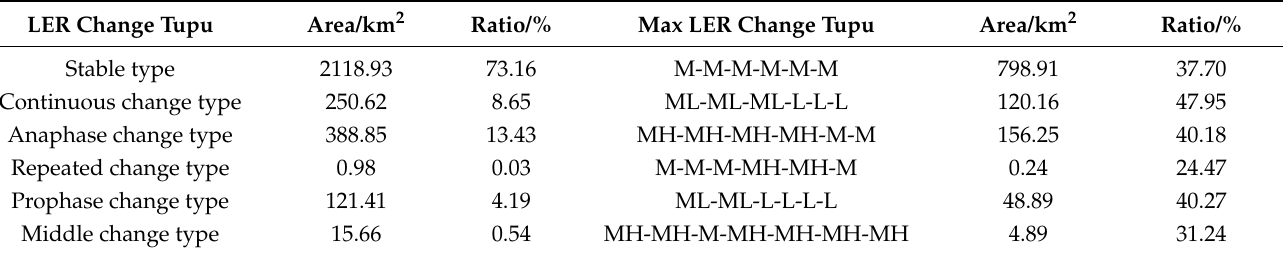
Table 2. Statistics on the area and proportion of LER change Tupu type in the Dianchi Lake basin of